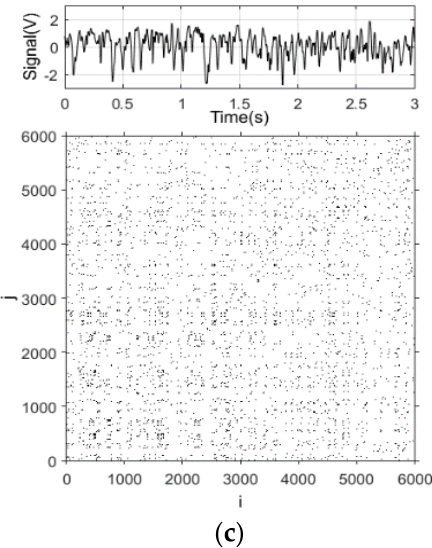
Figure 8. Recurrence plots under typical flow patterns of gas–water two-phase flows. ( a ) U sg = 0.055 m/s, U sw = 0.443 m/s, slug; ( b ) U sg = 0.590 m/s, U sw = 1.105 m/s, churn; ( c ) U sg = 0.055 m/s, U sw = 0.884